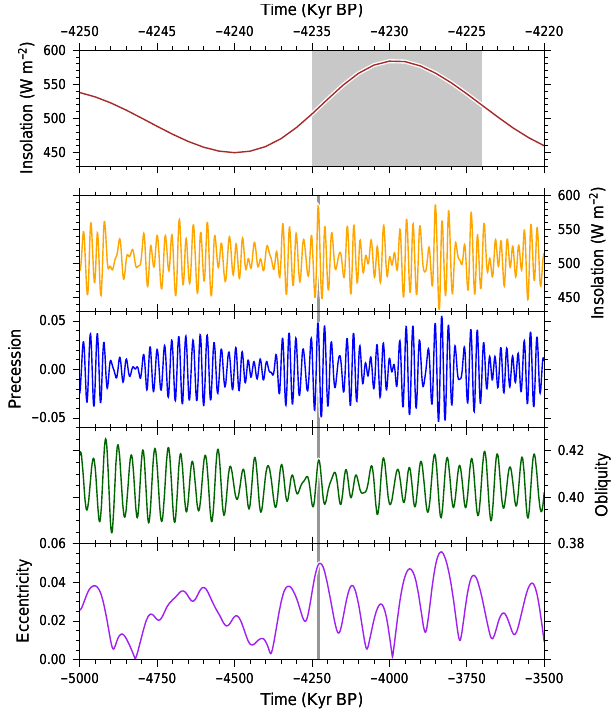
Figure 1. Orbital components and net January insolation at 80 ◦ S for the period 3.5–5Ma. Top panel shows insolation for the inter- glacial in which peak Pliocene values occur (grey shading). The insolation peak occurs at 4.23Ma. Data from Laskar et al.